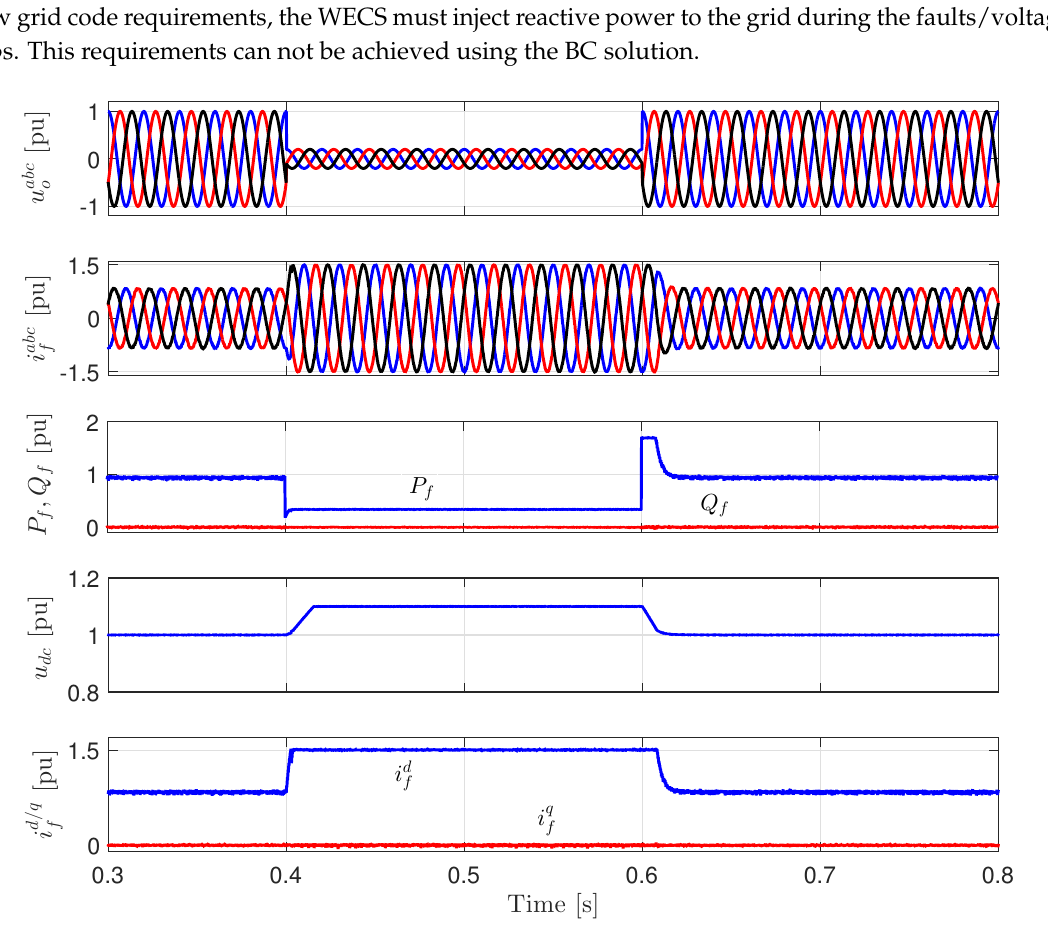
= ( i a ) (cid:62) , active and , i b , i c f f f f